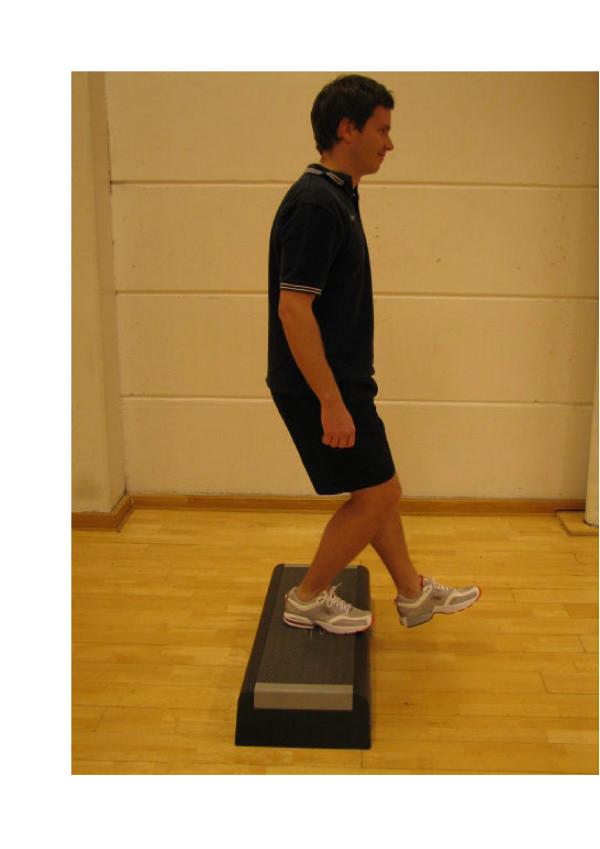
Stepping forward down from a step board with knee control on both the "supporting knee" and the "step down knee".